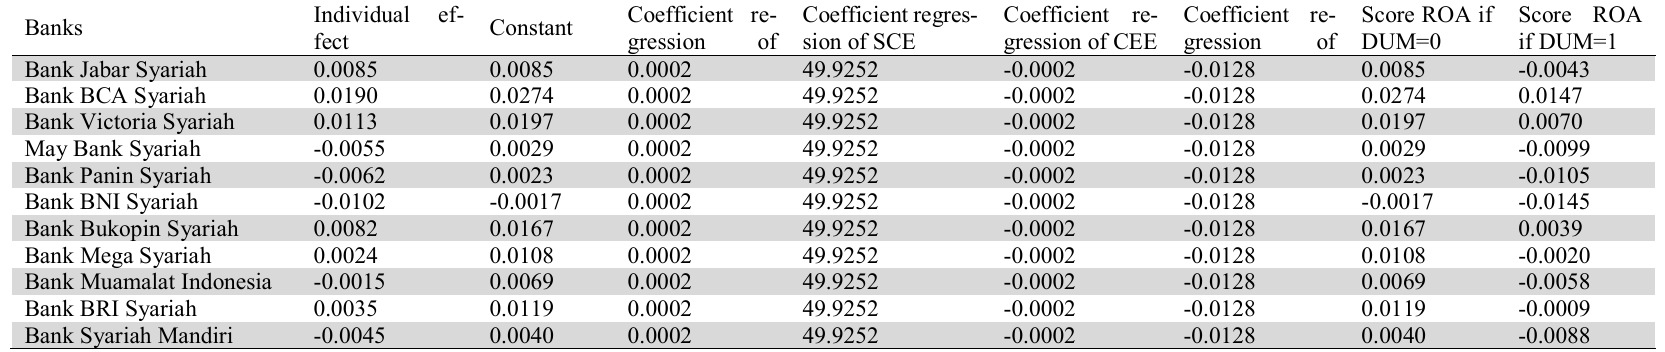
Return on Assets of banks Banks in Indonesia which have a Competitive Advantage